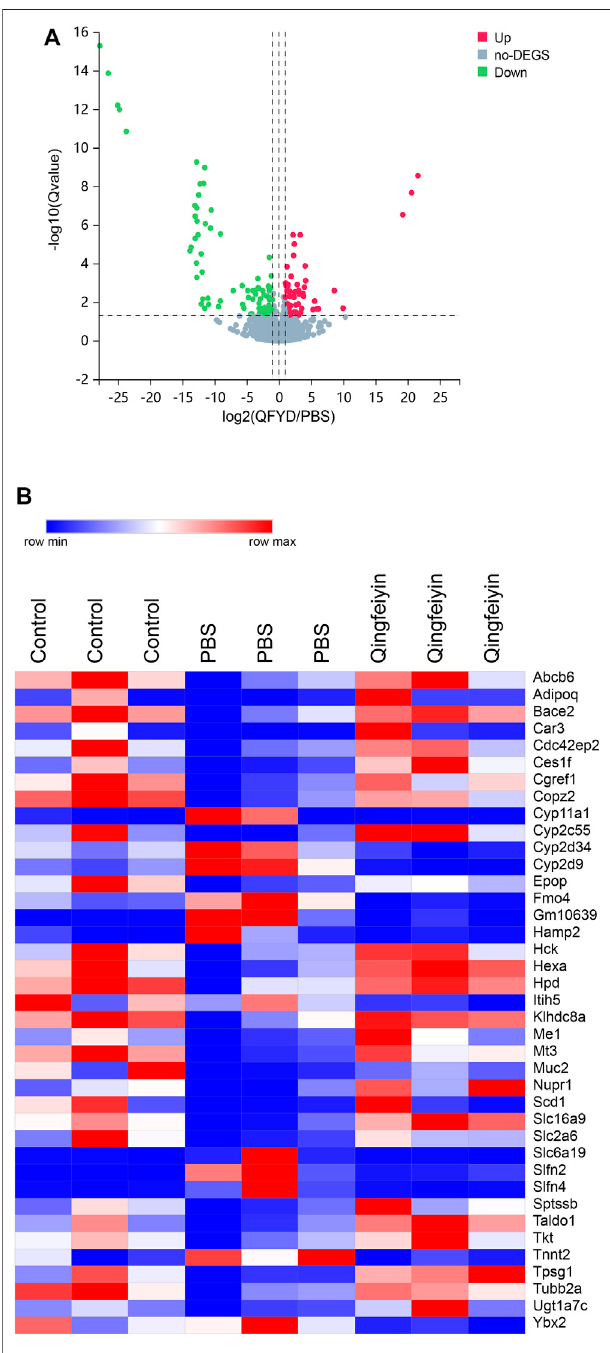
FIGURE 3 | The overview of lung transcriptome of colon tissue. (A) , a volcano plot of up and downregulation genes. (B) , a heatmap of differential